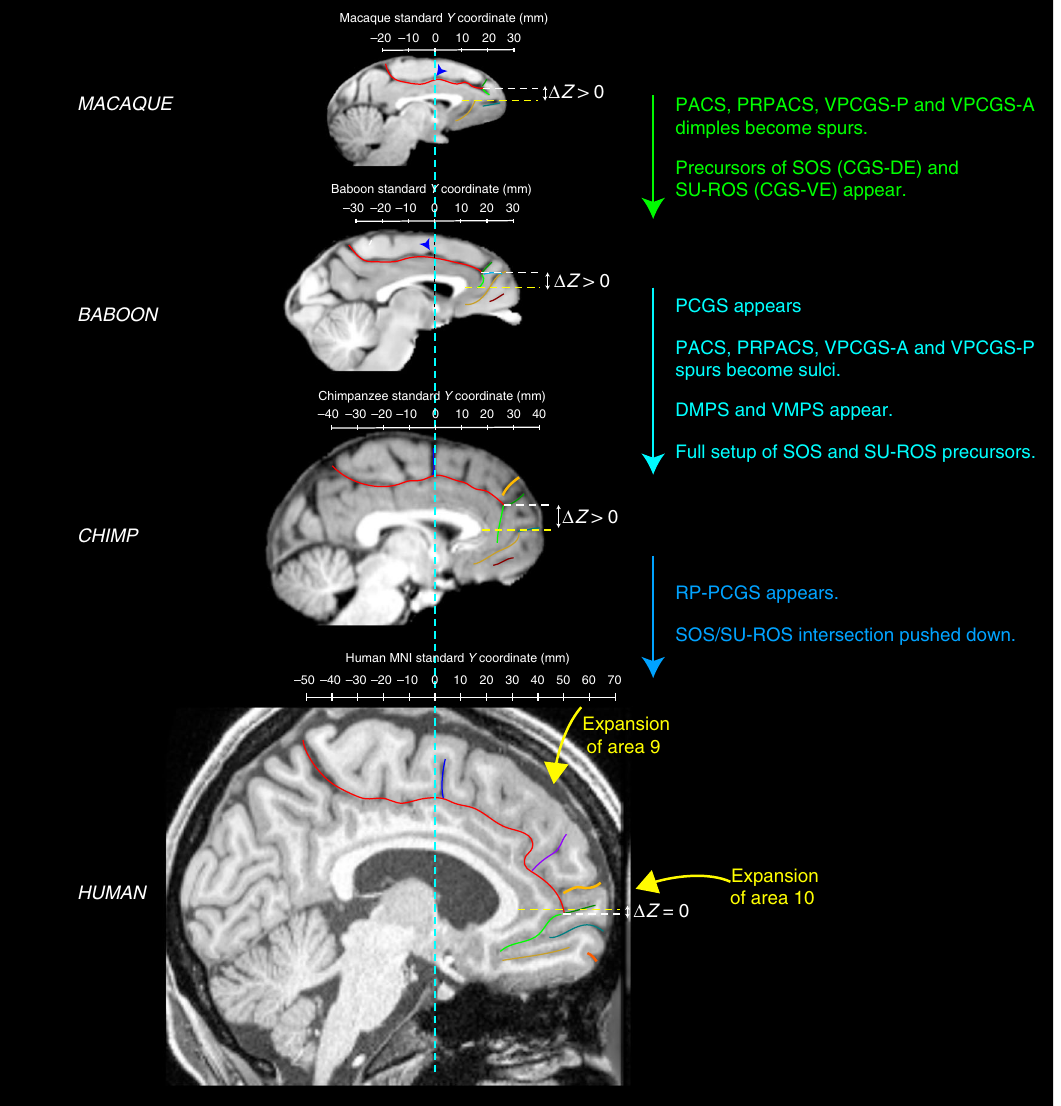
Fig. 8 Summary of sulcal changes occurring from macaque to human. Schematic sulcal organization of the MFC in each species is represented in their respective stereotaxic space. Main changes from one species to another are indicated. The Δ Z corresponds to the difference between the dorso-ventral Z coordinates where the intersection is observed and the dorso-ventral Z coordinates where the rostral limit of the genu of the corpus callosum is located. The difference Δ Z is decreased in the human compared to non-human primates, showing that the intersection between the CGS with the SU-ROS/CGS-VE and with the supra-orbital sulcus SOS/CGS-DE is pushed down from non-human to human